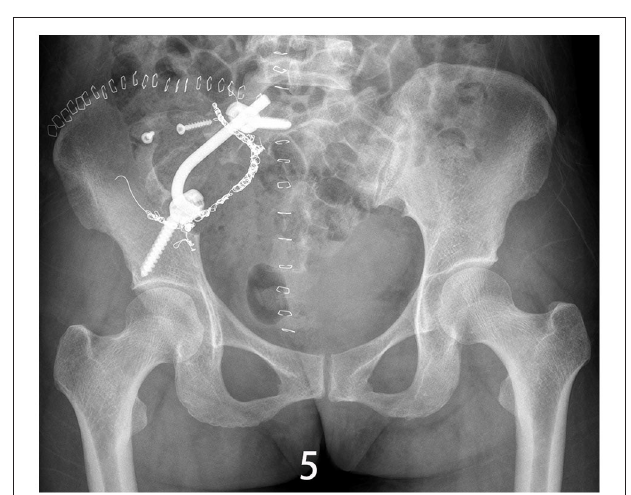
FIGURE 5 | X-ray/CT image of the sacroiliac joint showing synovectomy and arthrodesis followed up 1.5 years after surgery.